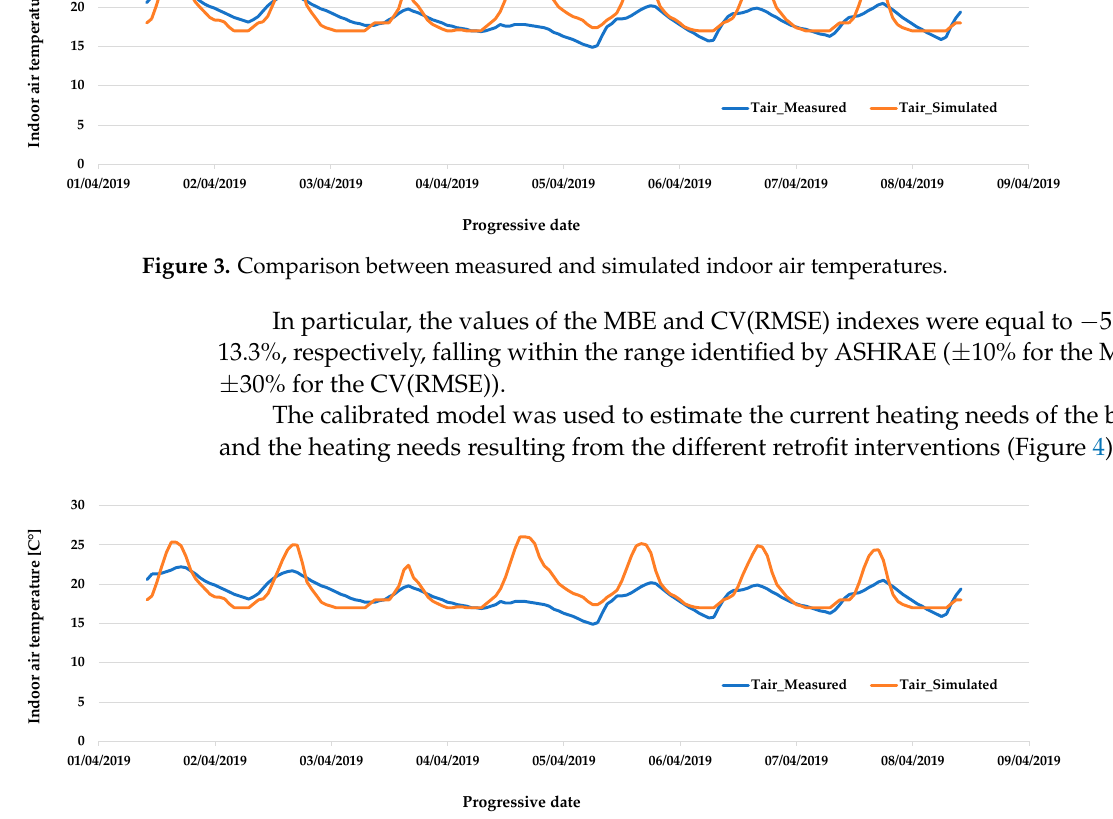
Figure 4. Annual consumption of primary energy for heating (kWh/y) of the various scenarios.